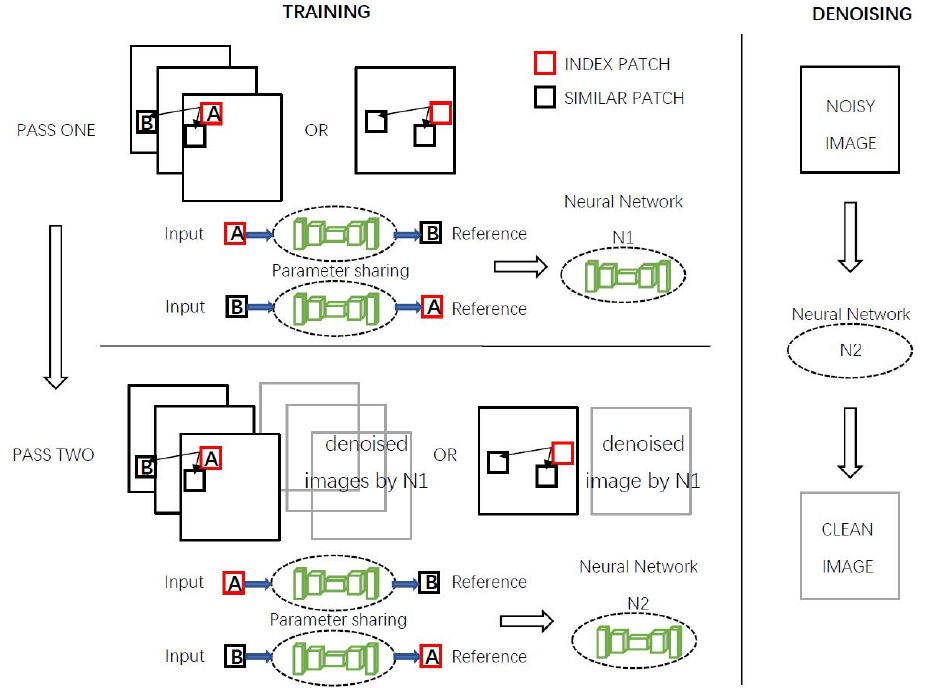
Figure 2. The workflow of the proposed BM-NR-DL method. Each noise2noise training pair con- tains an index patch A and a similar patch B. There are two training passes, and the second pass searches the similarity patches by considering the denoised result of the first pass. The similarity patch search could be carried out in either one noisy image or multiple ones. could be carried out in either one noisy image or multiple